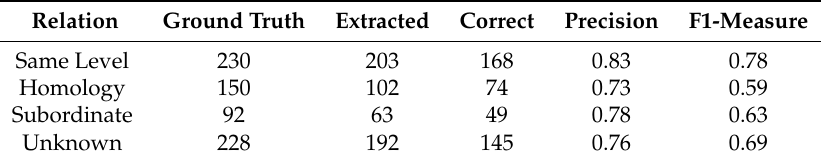
Table 9. Evaluation of triple extraction on the test set.